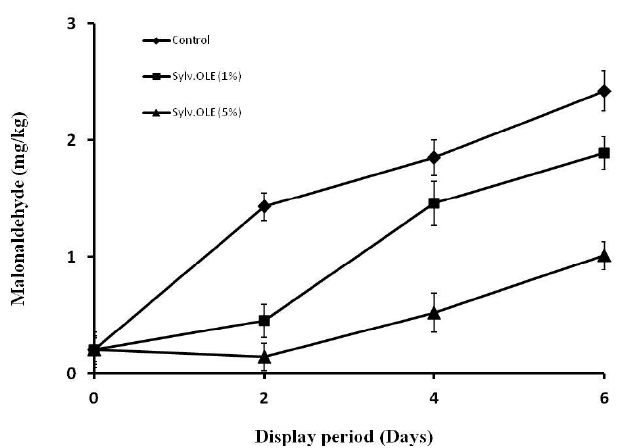
Figure 5. TBARS (thiobarbituric acid reactive substances) values (mg MDA/kg) during display of HMB containing different sylv . OLE concentrations.